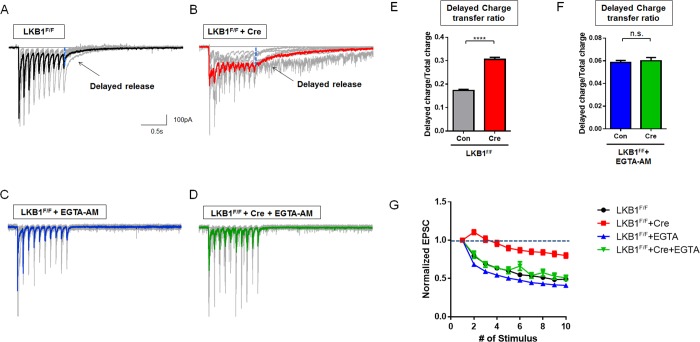
Conditional LKB1 deletion in cortical neurons abolishes short-term depression and increases asynchronous neurotransmitter release in a calcium-dependent manner.(A–D) Conditional deletion of LKB1F/F cortical neurons was achieved by infection at 3–4 DIV with lentiviruses expressing Cre recombinase (B) or control only (A) followed by whole-cell patch-clamp recording in voltage-clamp mode at 15–18 DIV. LKB1-deficient cortical pyramidal neurons leads to abrogation of short-term depression of neurotransmitter release following repetitive stimulation (10 AP at 10 Hz), which was rescued by application of cell permeant calcium chelator (100 μM EGTA-AM 10 min. prior to recording; C, D). (E and F) Increased delayed release (measured after last AP during stimulation) in LKB1-deficient cortical neurons (E) was attenuated by EGTA-AM incubation (F). (G) Normalized eEPSC amplitudes plot following each AP stimulation during 10 Hz shows impaired short-term depression of evoked neurotransmitter release in LKB1-null neurons (red curve) compared to control neurons (black). Addition of EGTA-AM restored the short-term depression phenotype of LKB1-deficient neurons (green) back to control levels (blue). n = 321 responses from 22 neurons for control, 334 responses from 28 neurons for LKB1-deletion, 212 responses from 25 neurons for control+EGTA-AM, 90 responses from 8 neurons for LKB1-deletion+EGTA-AM. **** p < 0.0001, Mann-Whitney test. Individual values are available in S1 Data.